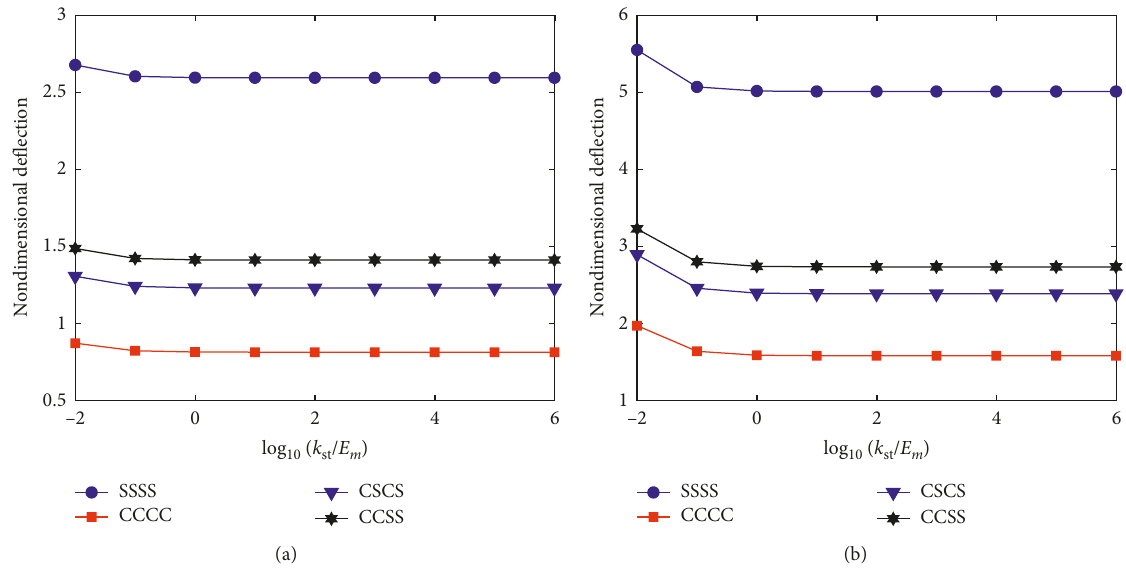
Figure 6: The effect of ratio k / E m on nondimensional deflection of the plate with a / b � 1: (a) h n / h m � 1; (b) h n / h m � 2. st